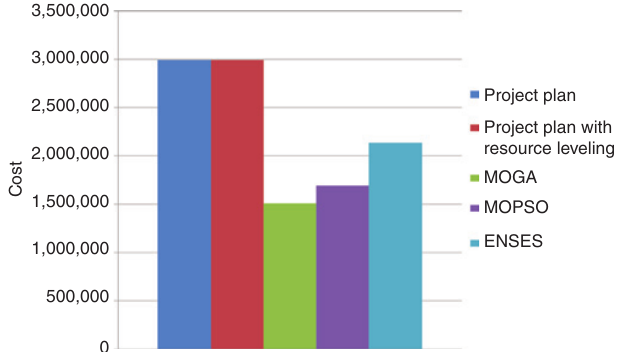
Figure 8: Project Cost of All Techniques.